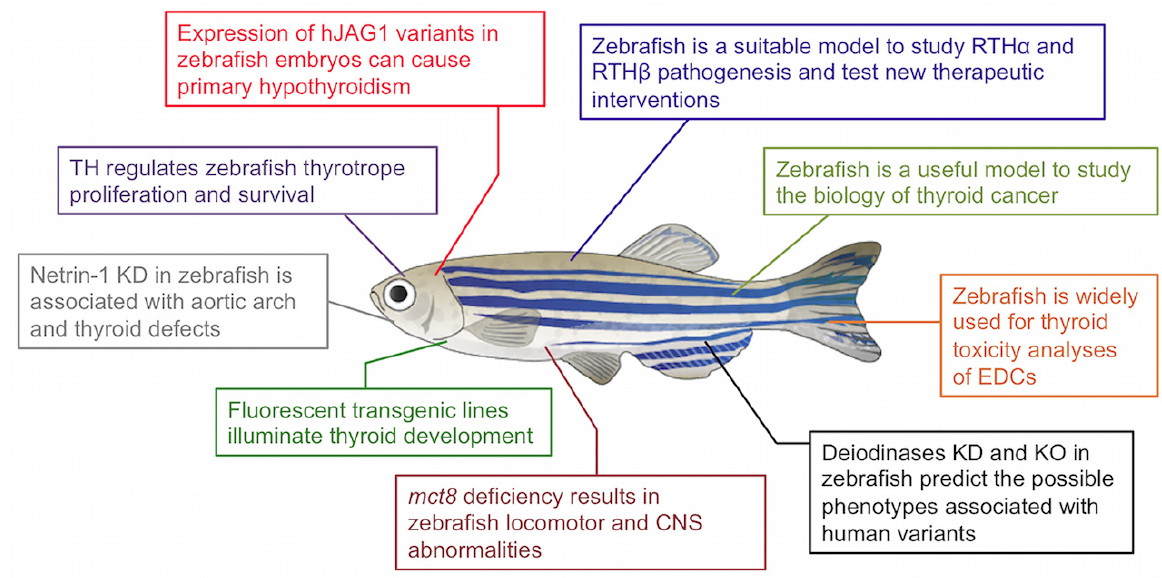
Figure 1. Schematic illustration of the most recent findings concerning thyroid development and thyroid hormone (TH) action that have been obtained using zebrafish as a model system. CNS, central nervous system; EDC, endocrine disruptor chemical; KD, knockdown; KO, knockout; mct8, monocarboxylate transporter 8; RTH, resistance to thyroid